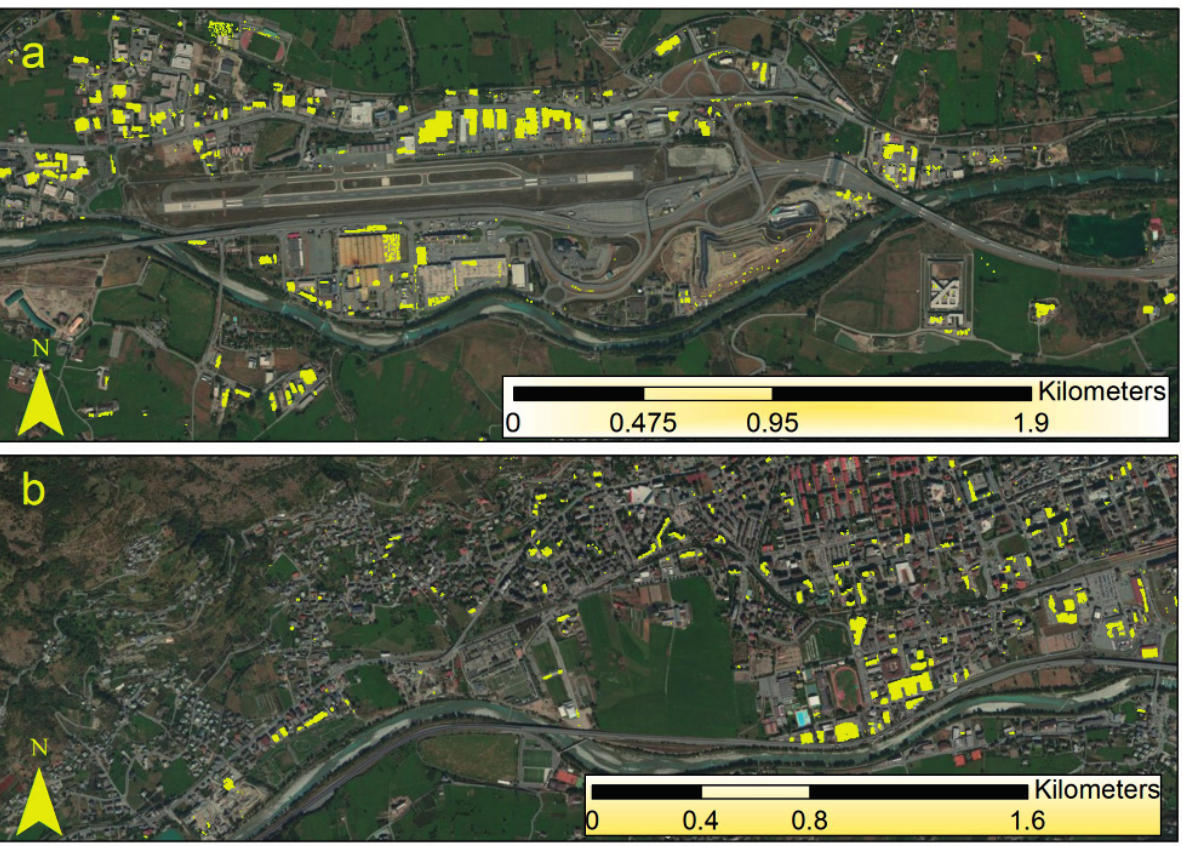
Figure 3. Examples of asbestos-cement roofs detection (yellow polygons) overlaid on the ortho-photos. ( a ) Commercial area near Aosta; ( b ) South-west side of